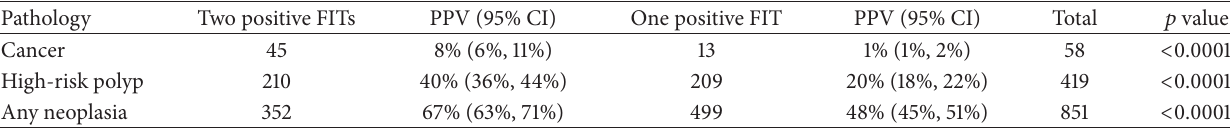
Figure 1: Flow chart demonstrating the study cohort. Table 1: Positive predictive value of one versus two positive FITs.